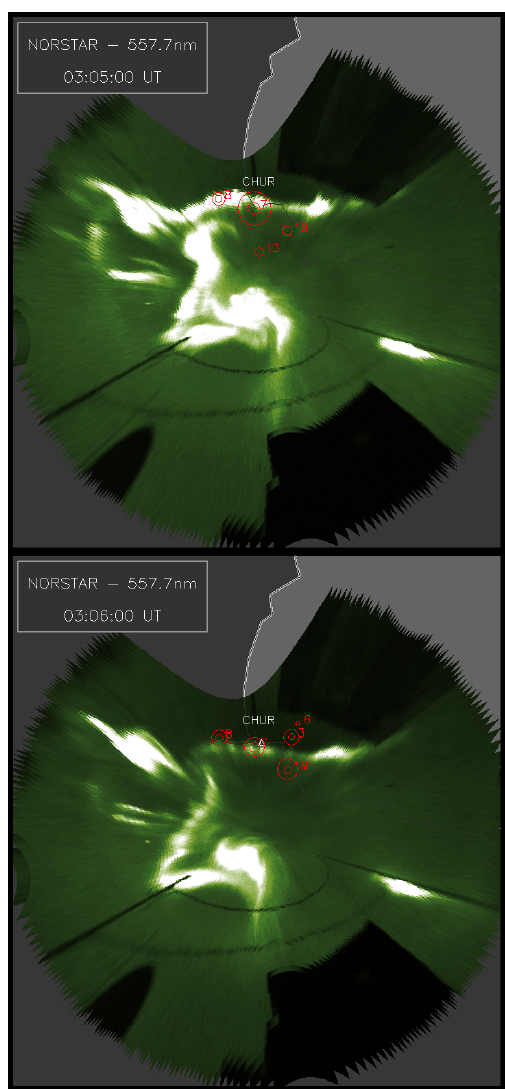
Figure 11. The mapped 557.7nm auroral emission observed in Gillam at 03:05 and 03:06UT on 9 March. The IPPs of five GPS satellites for the receiver in Churchill are shown as circles scaled proportionally to the 30s sDPR values between 2 and 35mms − 1